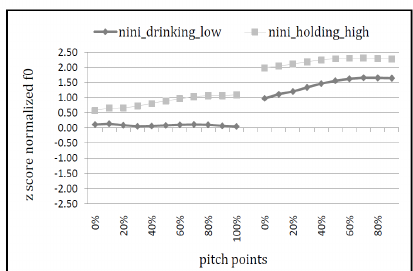
Figure 17: Normalized pitch contours for [nini], (n=20{5 speakers*4 iterations each})